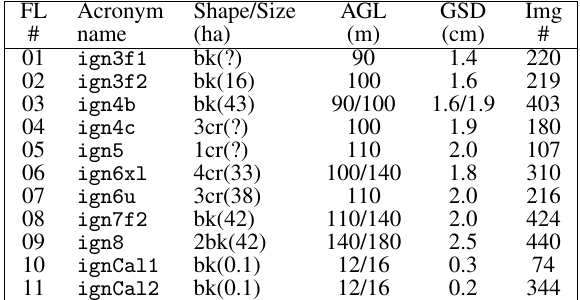
Table 6. Overview of acquired data during summer 2018.